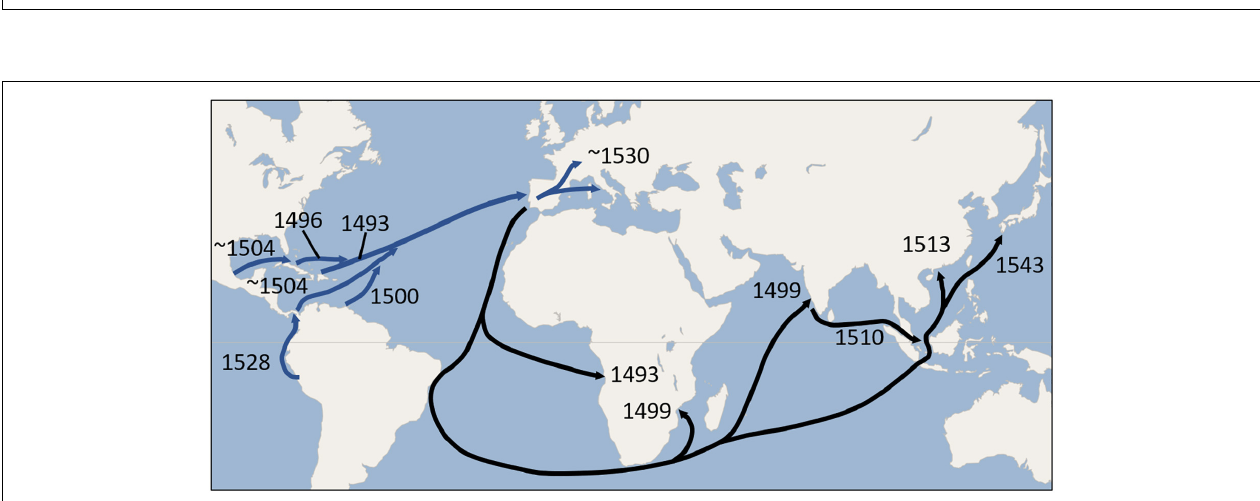
FIGURE 11 | Possible routes and earliest dates for the movement of Phaseolus beans from the New World to Europe (blue arrows), and earliest possible dates for dissemination to Africa, India, and Asia (black arrows) during the 16th century. The routes depicted are mainly those of the Spanish and Portuguese who were the earliest to establish the trade routes. Exploration and trading along the African Atlantic coast predated the Columbian Exchange, but the earliest possible date for the introduction of beans from Europe would have been 1493. Introductions to Africa and Asia may have been carried directly from the New World as well as from Europe. Return voyages by ships engaged in the slave trade from the New World directly to Africa may have been particularly instrumental in introducing common bean to that continent.